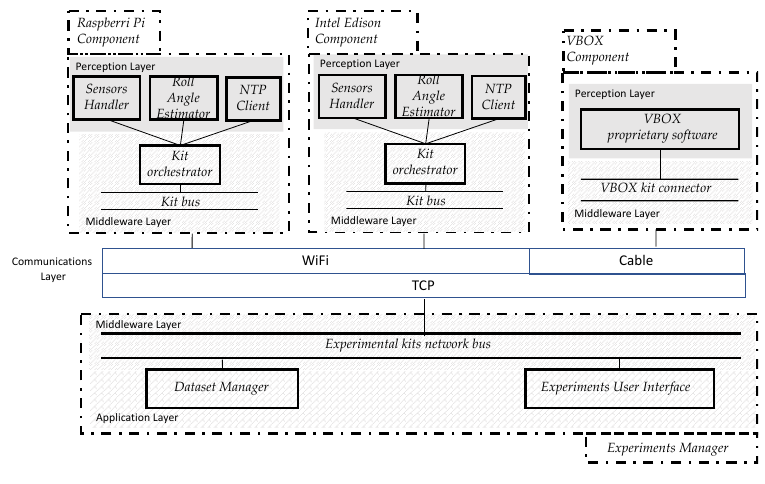
Figure 2. Testbed software design.